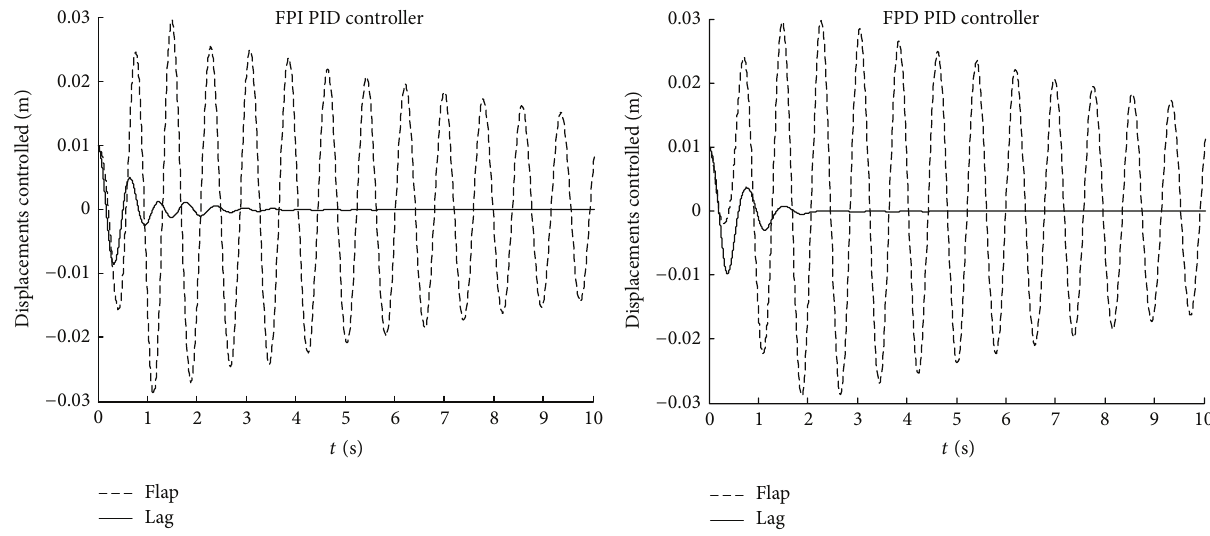
Figure 10: Flap and lag displacements of Case two for 𝑈 = 18 m s −1